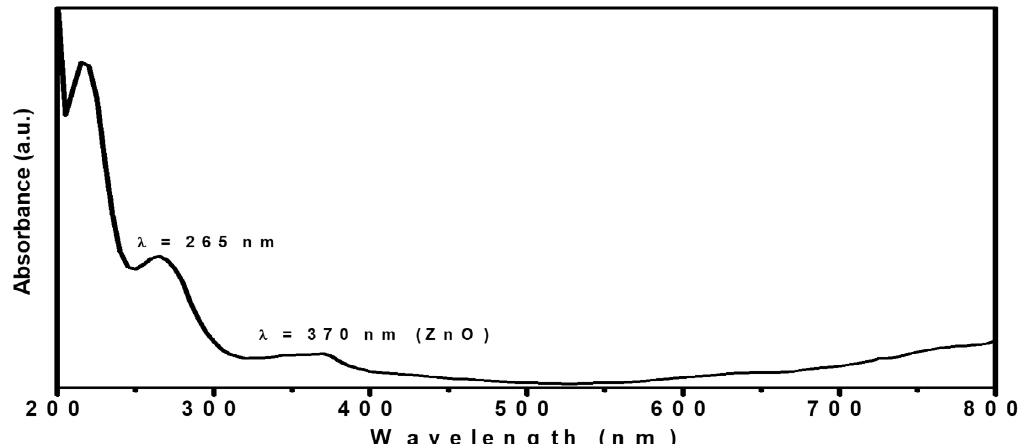
Fig. 4. The spectra of UV-Vis absorption of green synthesized ZnO NPs using (A. niger) extracellular extract.